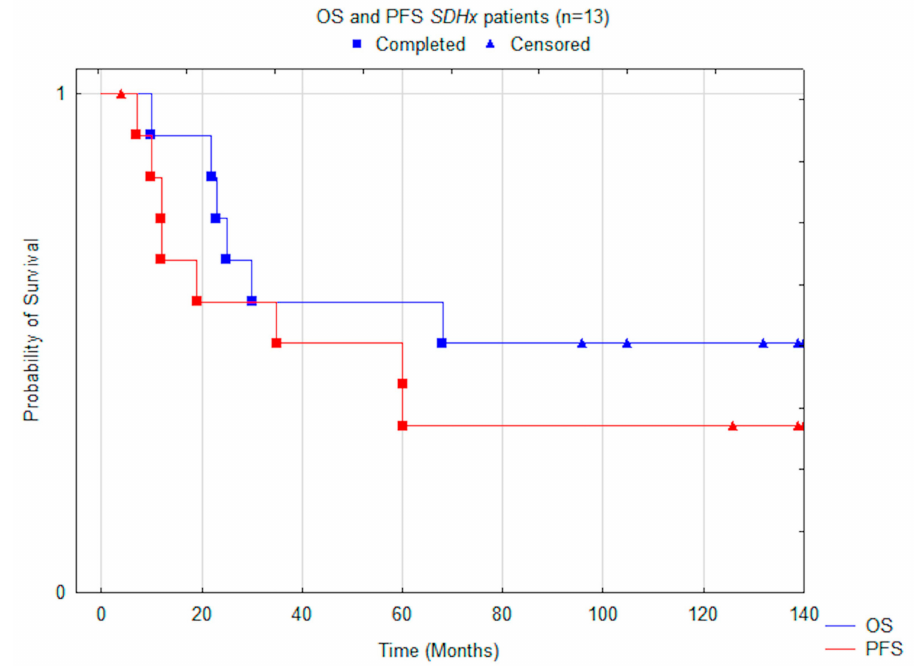
Figure 1. Comparison of median OS (overall survival) and PFS (progression free survival) using the Kaplan–Meier method, including all patients.